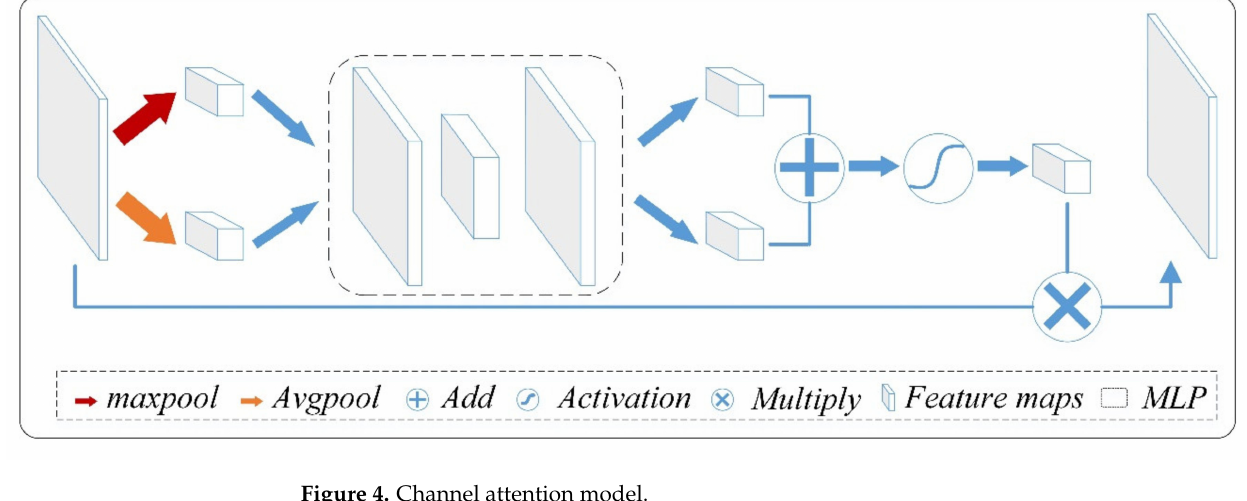
Figure 4. Channel attention